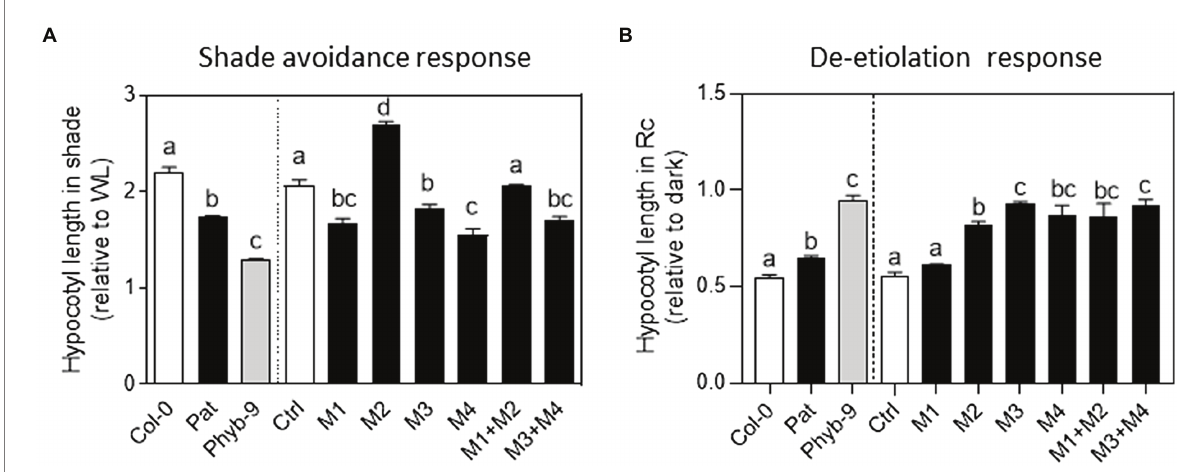
FIGURE 3 Functional variation of PHYB polymorphisms in shade avoidance response (SAR) and seedling de-etiolation response. (A) SAR index calculated as the ratio of hypocotyl length in simulated shade and WL. Each bar represents Mean ± SE ( n = 4). Significant differences between means are shown with different letters by one-way ANOVA followed by Bonferroni post-test ( p < 0.05). (B) Inhibition of hypocotyl length in red continuous light (relative to darkness) during seedling de-etiolation. Each bar represents Mean ± SE ( n = 4). Significant differences between means are shown with different letters by one-way ANOVA followed by Bonferroni post-test ( p <